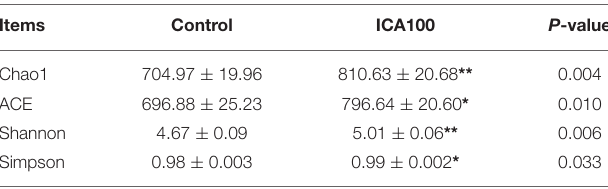
TABLE 4 | Alpha diversity of colonic microbial community in weaned piglets 1